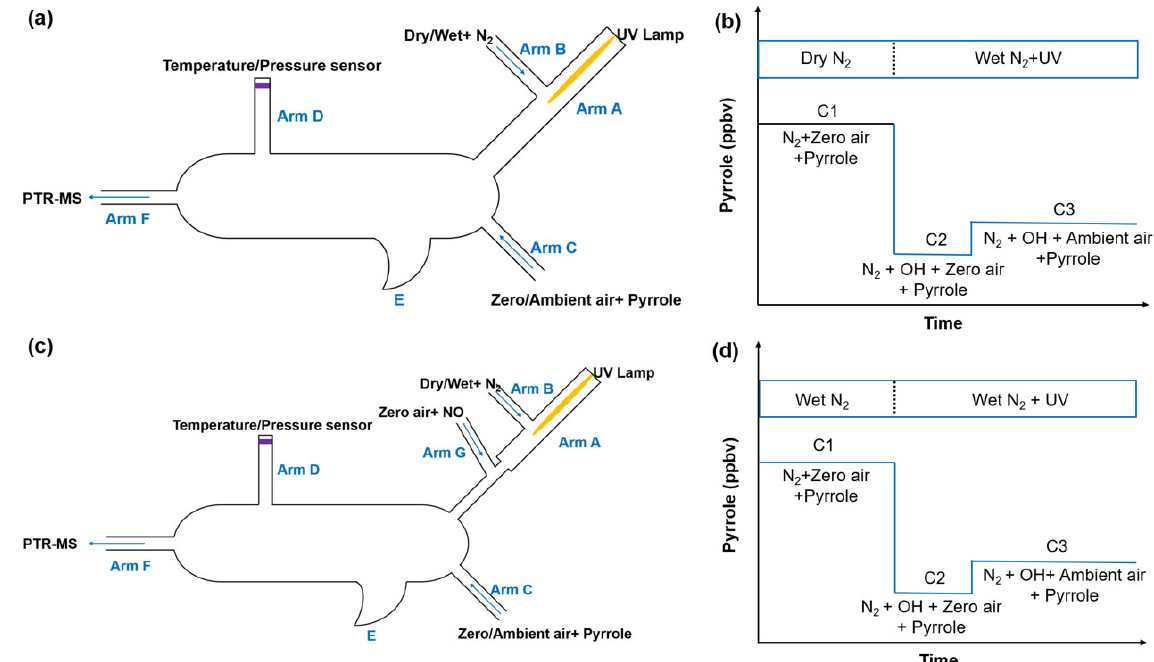
Figure 1. Schematic and work mode of the original CRM (Sinha et al., 2008, a , b ) and the ICRM (this study, c , d